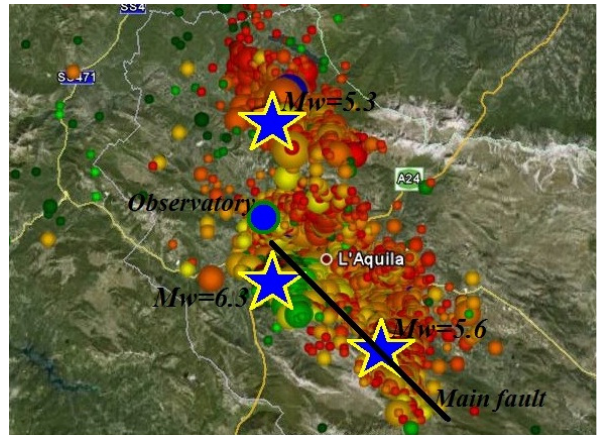
Fig. 10. Distribution of Earthquakes from 1 April to 20 April 2009 Fig. 10 Distribution of Earthquakes from April 1 to April 20,2009 around L'Aquila (Emanuele around L’Aquila. Cesarotti, INGV,Roma I)